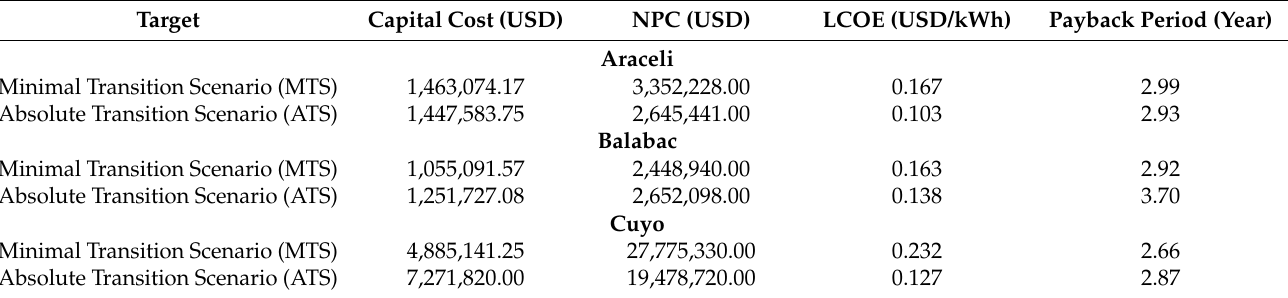
Table 5. The component economic cost of the most optimal configurations for MTS and